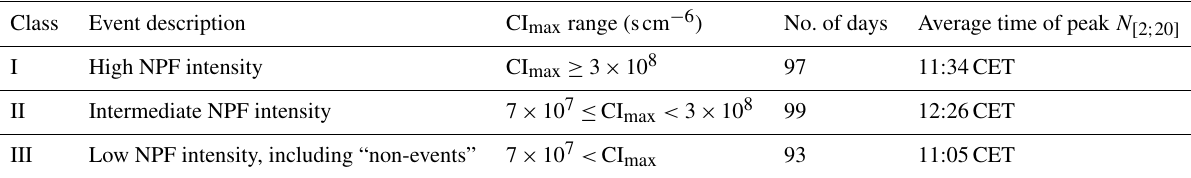
Table 2. Classification of NPF events according to their convolution integral peak (CI max ) and two specific threshold values based on the complete NAIS-TDMPS data